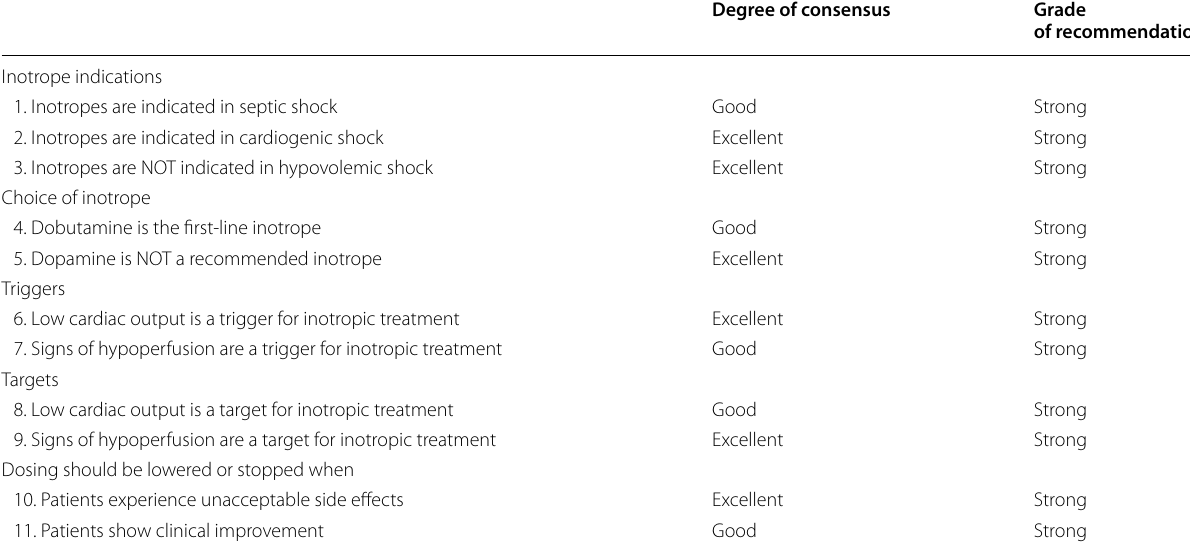
Table 3 Summary of consensus among experts and the degree of